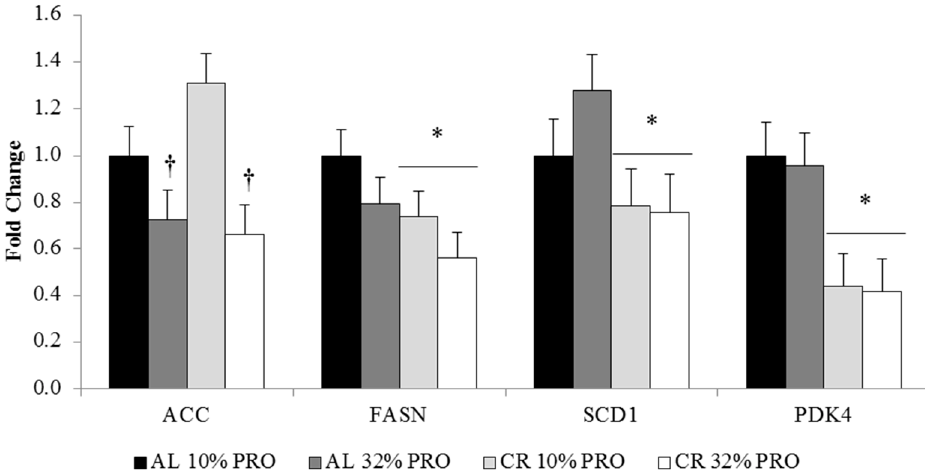
Figure 2. mRNA expression of lipogenic regulators. Values presented as mean ± SEM. * Main effect of calorie intake, CR different than AL; p < 0.05. † Main effect of protein intake, 32% PRO different than 10% PRO; p < 0.05. ACC: acetyl-CoA carboxylase; FASN: fatty acid synthase; SCD1: stearoyl-CoA desaturase; PDK4: pyruvate dehydrogenase kinase, isozyme 4.